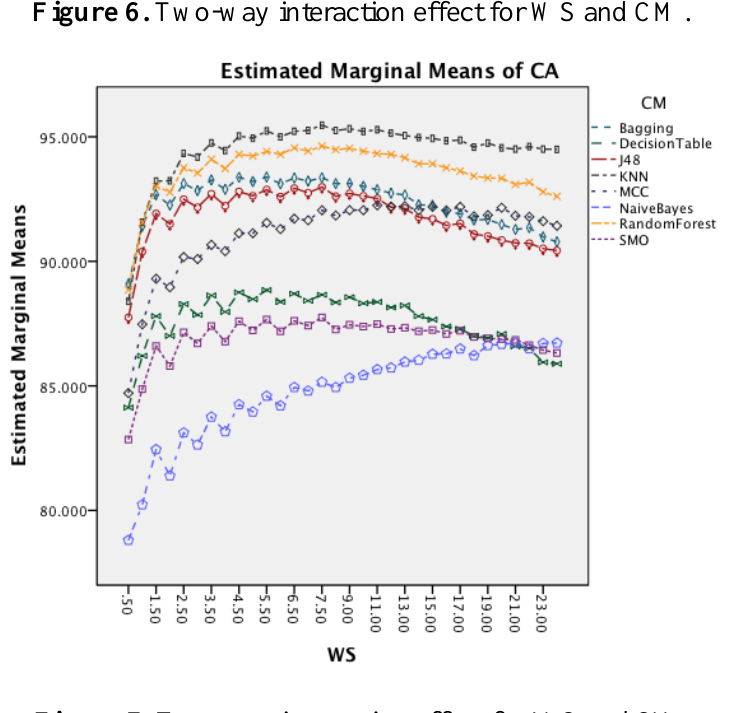
Figure 7. Two-way interaction effect for WS and